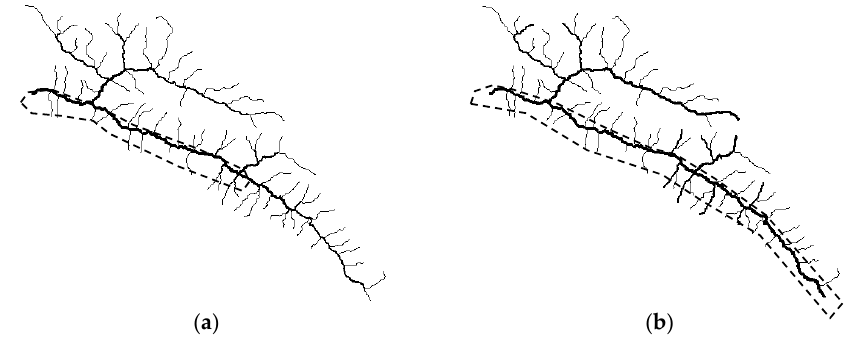
Figure 9. Tested river network for trellis case. ( a ) is the trellis network schemed by Horton-Strahler order; ( b ) is the network with Horton-Strahler order after upstream routine. The bolder the river tributary, the greater the Horton-Strahler order. Dashed polygons show the different main streams obtained owing to different order schemes.